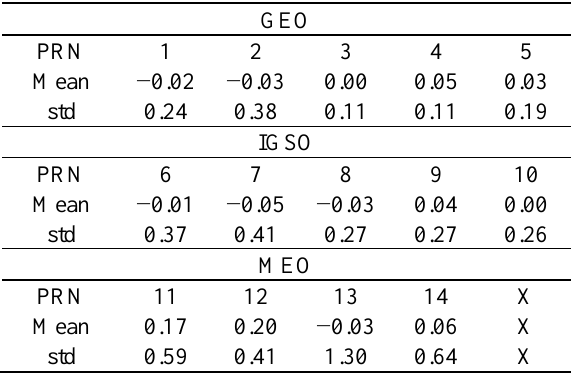
Table 4. Statistical results for BDS DQA2.